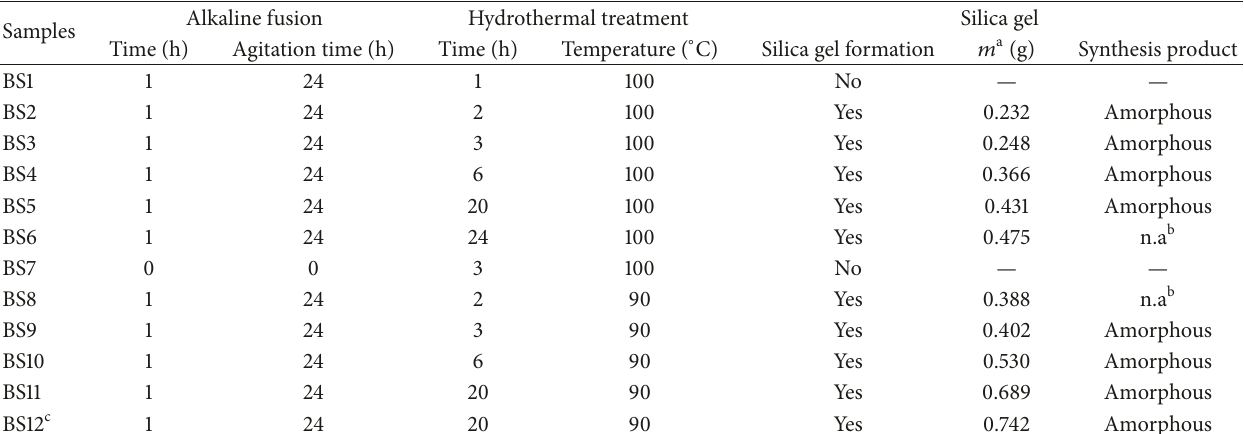
Table 1: Parameters of the biosilica synthesis process.